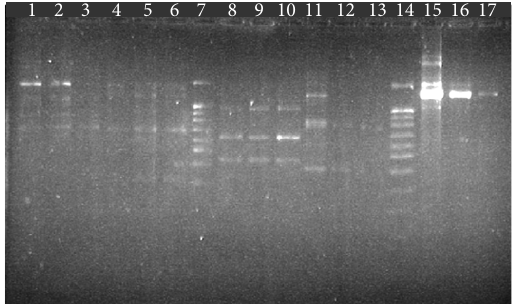
Fig. 3: Image of electrophoresis for PCR products on agarose gel